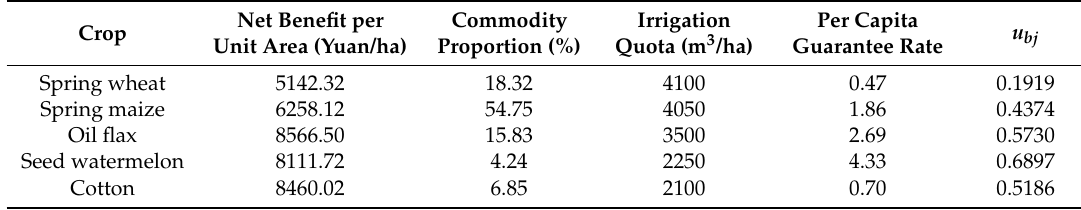
Table 3. Main indicators for u bj of different